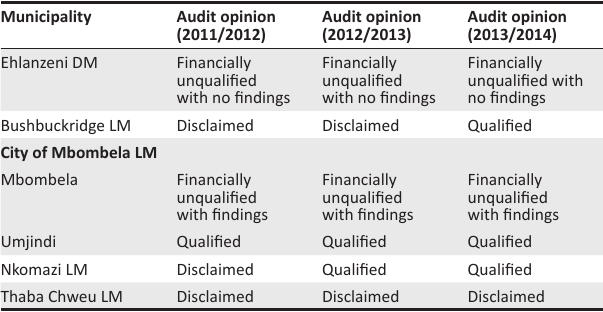
TABLE 1: Comparison of audit opinions for the Ehlanzeni District Municipality and local